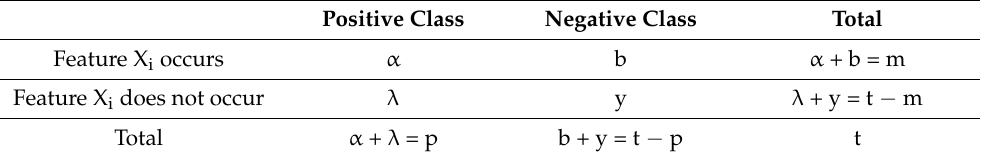
Table 2. Calculation table for the χ 2 test score [27]. Positive Class Negative Class Total Feature X i occurs α b α + b = m Feature X i does not occur λ y Total